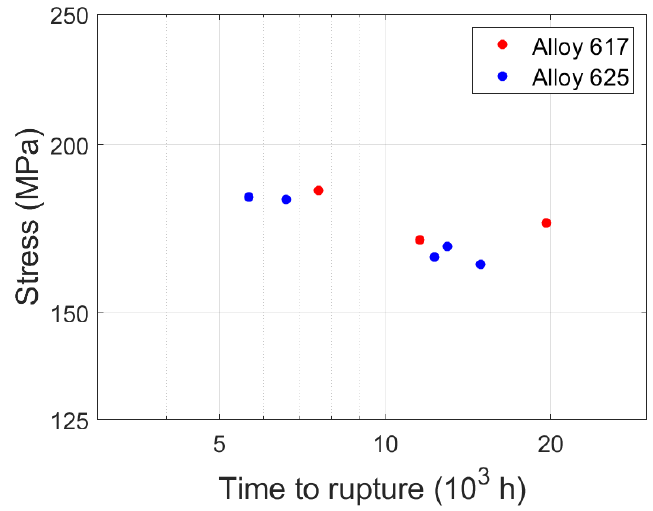
Figure 1. Time to rupture vs. stress for the specimens in this study.